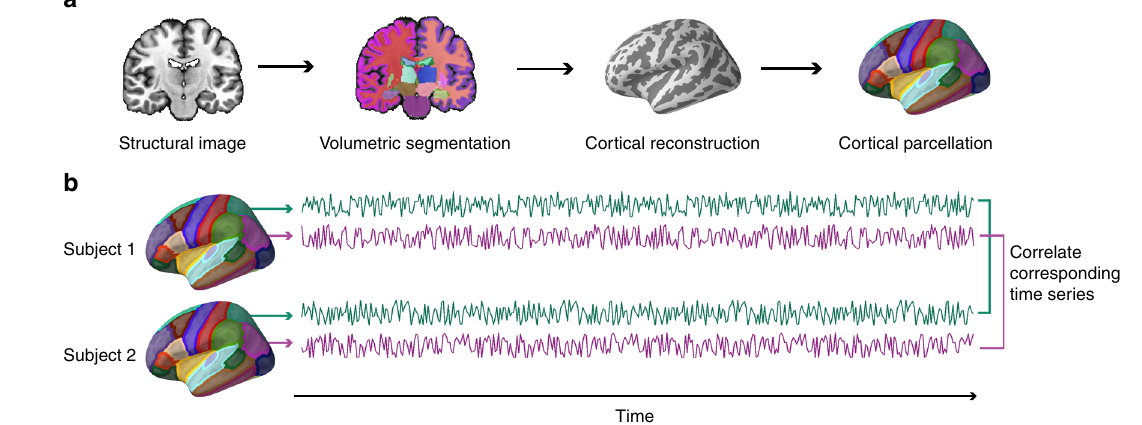
Fig. 2 Computing inter-subject time series correlations. a Eighty anatomical regions of interest (ROIs) were derived for each individual using the FreeSurfer image analysis suite 53 . Segmentation of cerebral cortex, subcortical white matter, and deep gray matter volumetric structures (e.g., hippocampus, amygdala, and putamen) was performed on the high-resolution scan of each individual ’ s brain volume. These structures are signi fi ed by color in the image demonstrating volumetric segmentation (e.g., the left and right cerebral cortex are shown in magenta and purple, respectively). Next, a cortical surface model was reconstructed and parcellated into anatomical units, which are signi fi ed by different colors in the cortical parcellation scheme illustrated on the far right. b For each individual, the average response time series within each ROI was extracted during video viewing. Next, the correlation between the time series extracted from each pair of corresponding ROIs was computed for each unique pair of logistic regression: ß = 0.128; SE = 0.137; p = 0.35), ethnicity